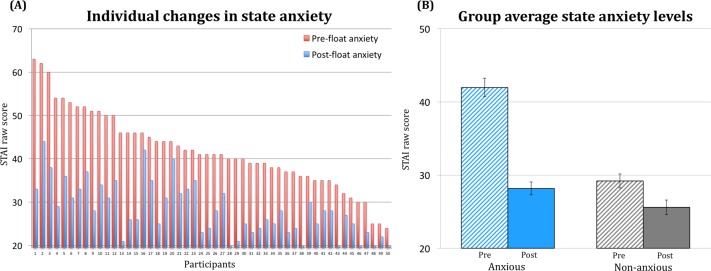
Impact of Floatation-REST on state anxiety.(A) The float experience caused a reduction in state anxiety that was evident across all 50 participants, leading to a significant pre- to post-float change on the Spielberger State Anxiety Inventory (STAI) at the group level [t(49) = -15.16, p < .0001, d = 2.15]. (B) Despite a large baseline difference, the anxious group’s average post-float anxiety had reached levels slightly lower than the pre-float anxiety reported by the non-anxious reference sample. Error bars represent the SEM.